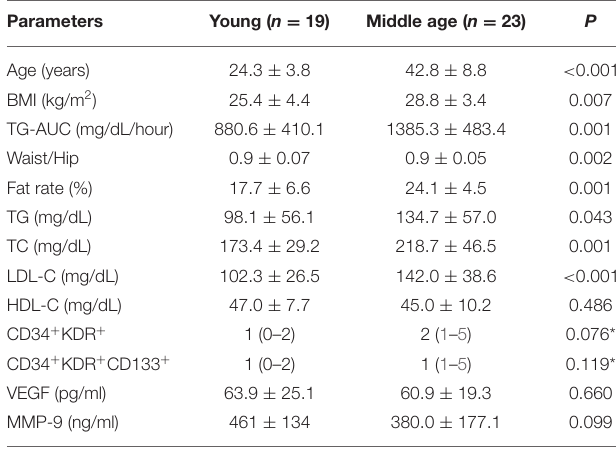
TABLE 4 | Physical characteristics and biochemical and immunological parameters according to the age in women. Parameters